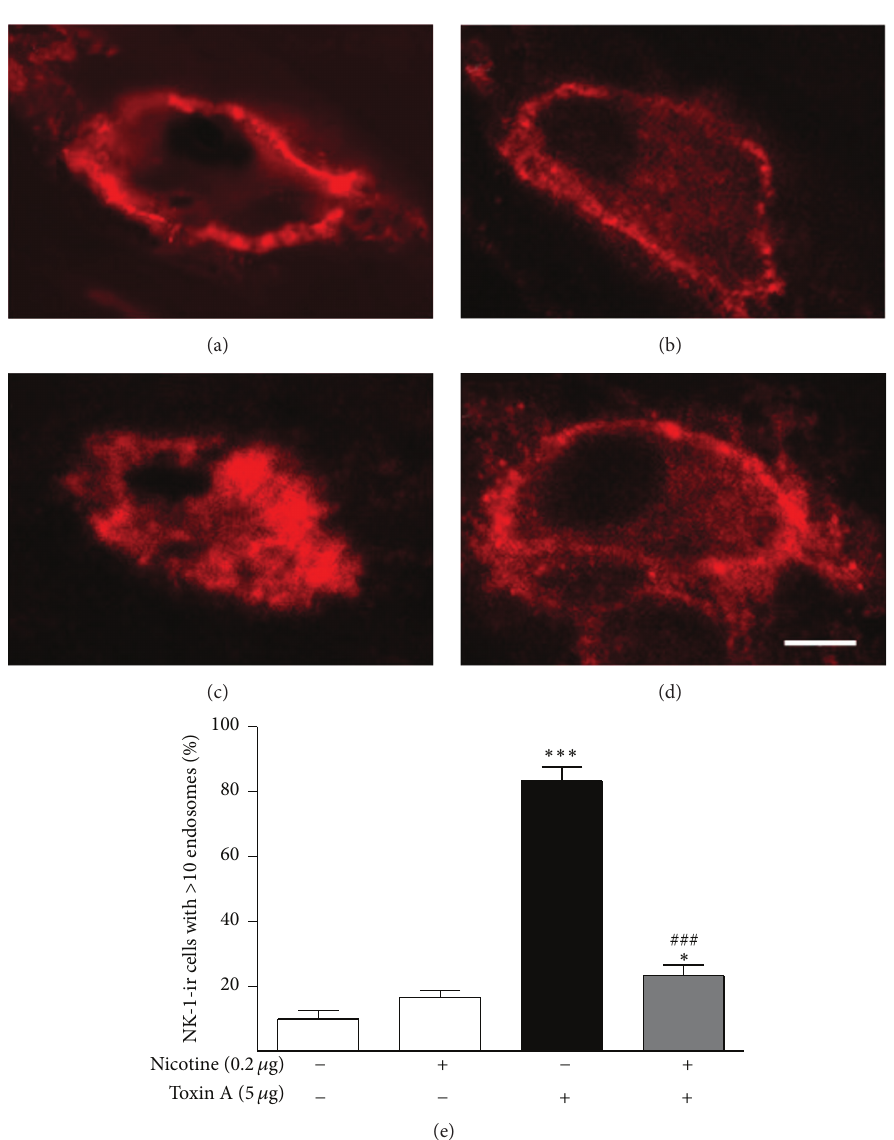
Figure 7: Effect of nicotine pretreatment on toxin A-induced release of endogenous substance P (SP) in the rat colon. (a) Confocal image of neurokinin-1 (NK-1) receptor distribution on a myenteric plexus neuronal ganglionic cell body in a control rat treated with vehicle. The NK- 1 receptor is localized on the plasma membrane. (b) Confocal image of neurokinin-1 (NK-1) receptor distribution on a myenteric plexus neuronal ganglionic cell body in a control rat treated with nicotine (0.2 𝜇 g). Nicotine alone has no effect on SP-induced NK-1 receptor endocytosis. (c) Confocal image of neurokinin-1 (NK-1) receptor distribution on a myenteric plexus neuronal ganglionic cell body in a rat treated with toxin A (5 𝜇 g). Toxin A causes endogenous SP release seen here as NK-1 receptor endocytosis. (d) Confocal image of neurokinin-1 (NK-1) receptor distribution on a myenteric plexus neuronal ganglionic cell body in a rat pretreated with nicotine (0.2 𝜇 g) before toxin A (5 𝜇 g). Nicotine prevented toxin A-induced SP release in colon. Line bar = 100 𝜇 m. (e) Quantitation of the effects of toxin A and nicotine on SP release in the rat colon. ∗ 𝑃 < 0.05 versus control; ∗∗∗ 𝑃 < 0.001 versus control; ### 𝑃 < 0.001 versus toxin A; 𝑁 = 6